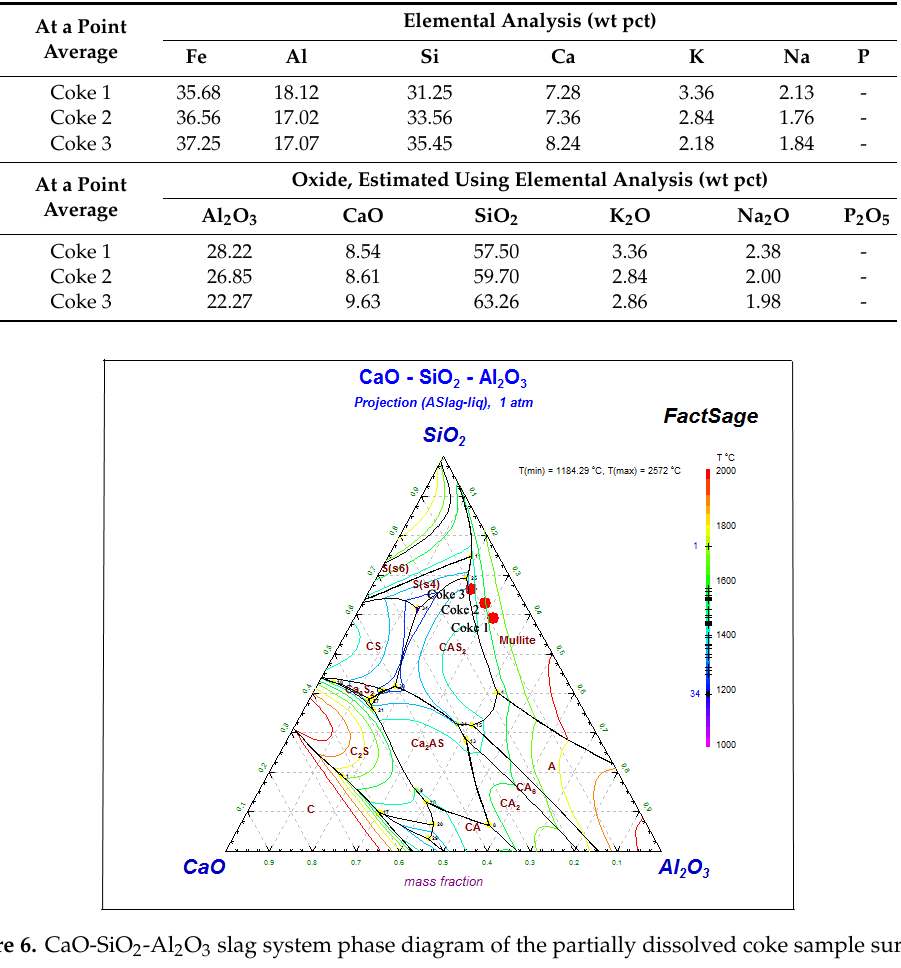
Figure 7. SEM image and EDS analyses of the reacted iron sample. 4.2. Effect of Sulfur on the Dissolution Rate Although the dissolution rate is not determined by the phase interface reaction, the active elements on the sample surface, such as sulfur, may hinder the interfacial reaction and affect